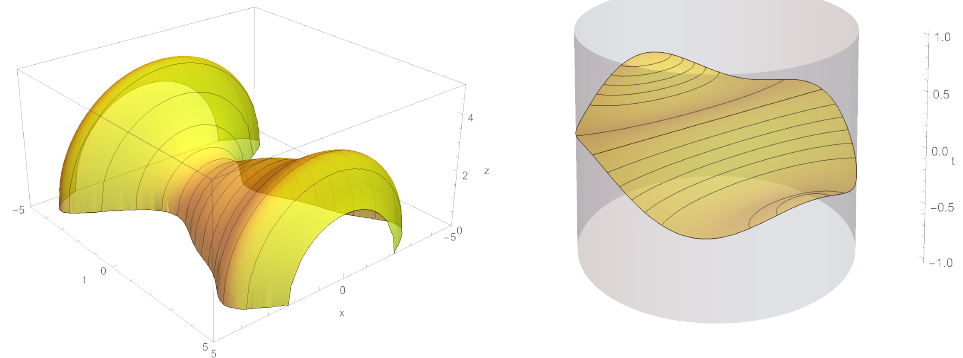
Figure 11: Left: Example of (85) for r ( t ) = 3 + 1 sin ( t ) − cos ( t 2 / 5 ) . This satisfies (71). 2 For this solution the sign of K switches in between points on the surface, hence k in (73) can not be globally absorbed into the normalisation of m . Note we are working in the Euclidean case, so the norm of m has to be positive. Right: Example of (88) ( φ ) [ φ ] = 1 for t cos ( 4 φ ) − cos . The asymptotic boundary of global AdS is depicted bd y 8 4 as a grey